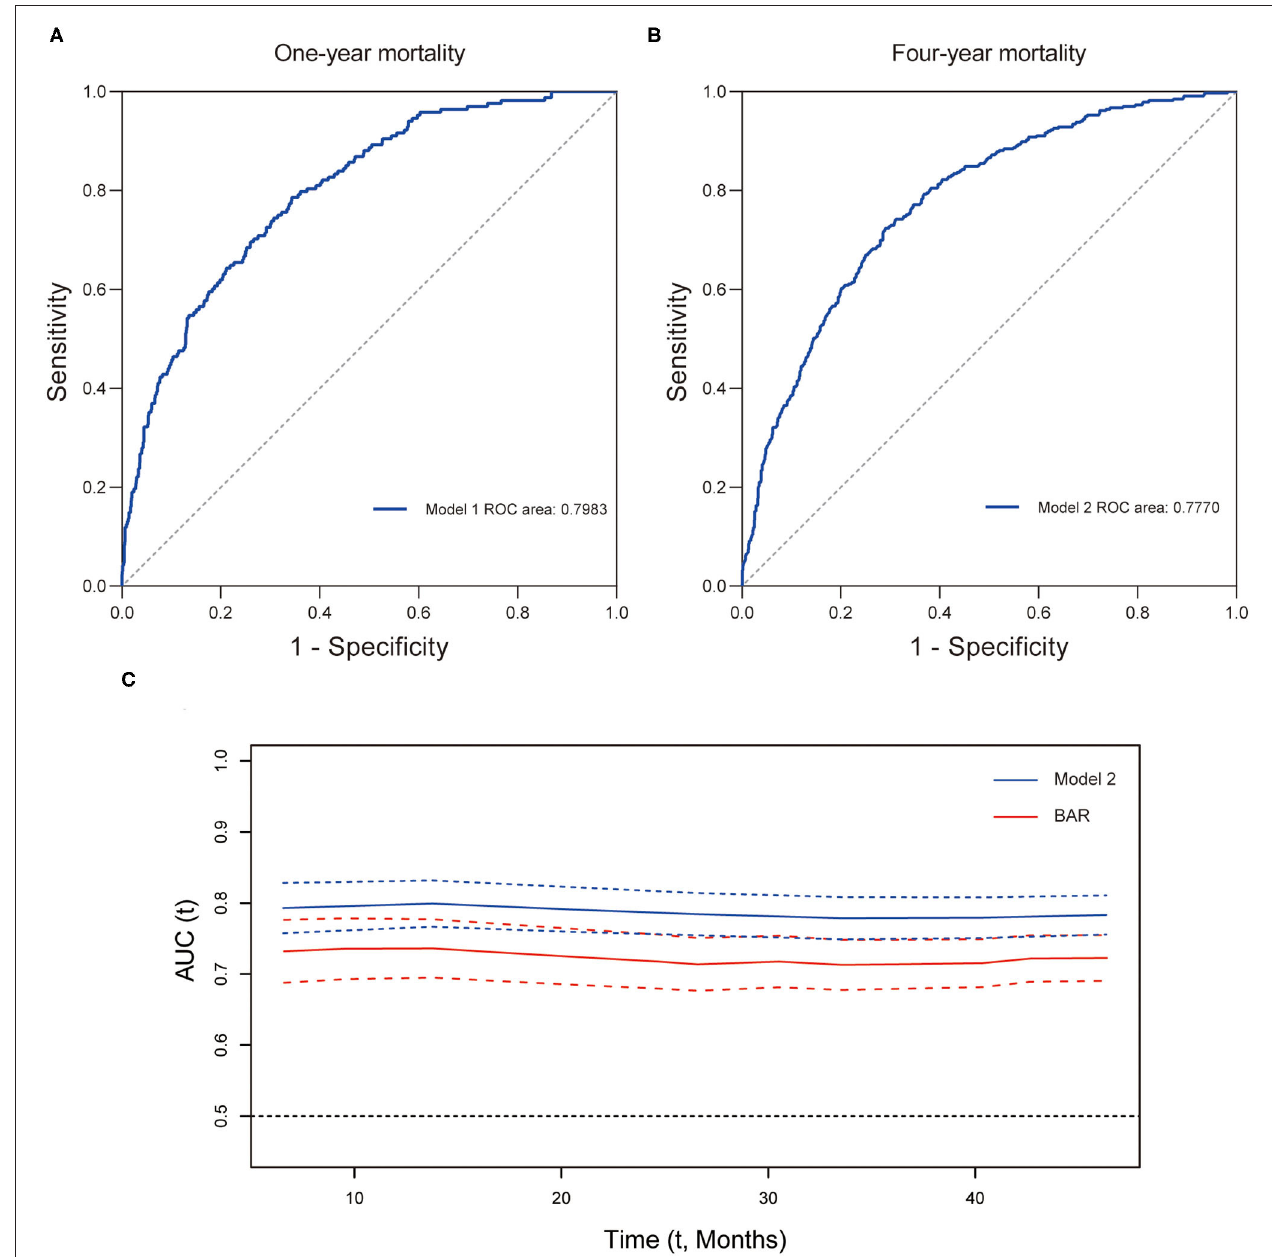
FIGURE 5 | The predictive value of prognostic models for long-term mortality in CABG patients. ROC curve for 1- (A) and 4-year (B) mortality. (C) Time-AUC curves of model 2 and BAR. CABG, coronary artery bypass grafting; ROC, receiver operating characteristic curve; AUC, area under the ROC curve; BAR, blood urea nitrogen-to-albumin